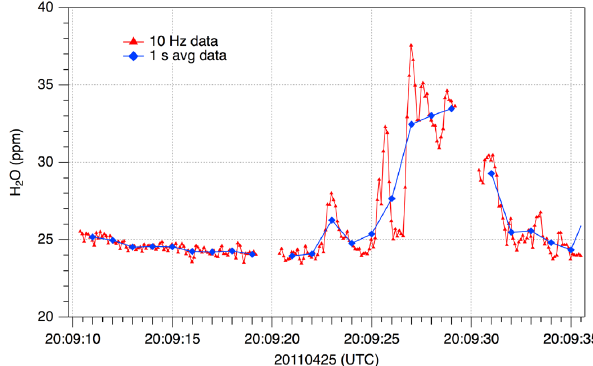
Fig. 12. Time series of CIMS H 2 O 10Hz data (red triangles) and corresponding 1s averages (blue diamonds) during sampling within a cirrus cloud on the flight on 25 April 2011. The 10Hz data re- veal additional structure in the H 2 O mixing ratio on smaller spatial scales ( ∼ 20m) than those resolved with the 1s data ( ∼